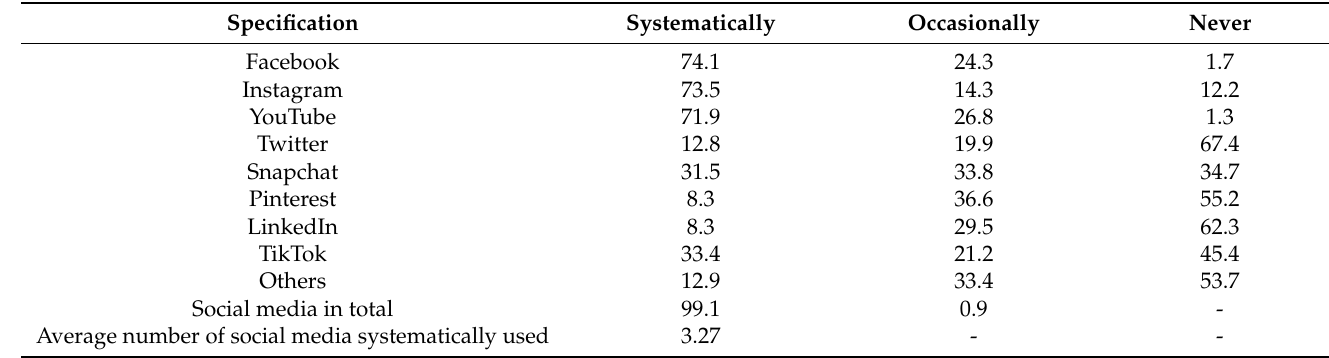
Table 2. The frequency of using social media (in %).